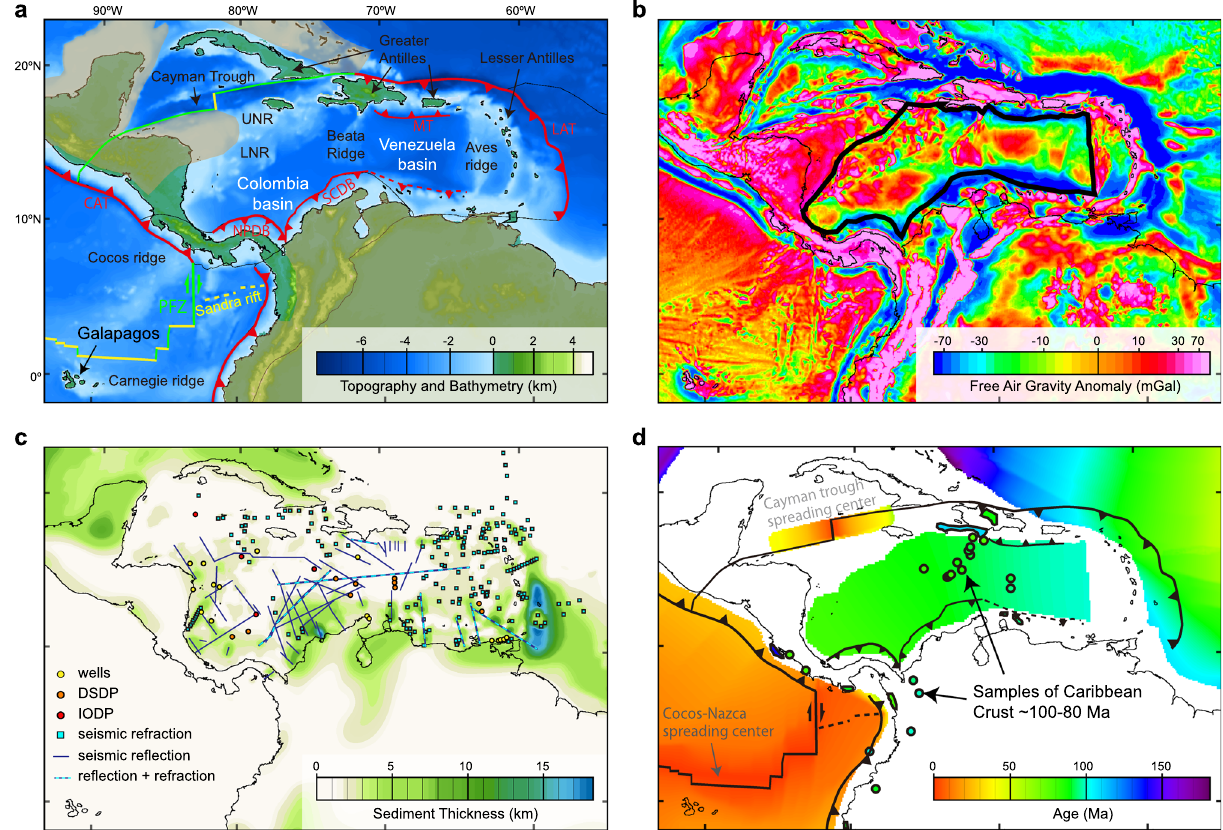
Fig. 1 Maps of the Caribbean study area. a Topographic and bathymetry. Plate boundaries of Bird 73 are colored-coded as active spreading centers (yellow lines); extinct spreading centers (yellow dashed lines); transform (green lines); subduction zones (red lines with teeth). LAT lesser Antilles trench, CAT central America trench, NPDB north Panama deformation belt, SCDB south Caribbean deformation belt, MT Muertos trench, PFZ Panama fracture zone, UNR upper Nicaraguan rise, LNR lower Nicaraguan rise. Dark orange shaded areas show continental crust 74 . b Satellite free air gravity anomaly 33 . The Caribbean oceanic plateau is bounded within the bold black line. c Sedimentary thickness constrained by seismic re fl ection, refraction, and borehole (see Supplementary Note 2 for references). d Age of the oceanic lithosphere from marine magnetic anomalies 75 with Caribbean lithospheric ages slightly shifted to between 100 and 80 Ma based on recent dating results 30 , and references therein (see “ Methods ” for details). Bold black lines are plate boundaries as in ( a